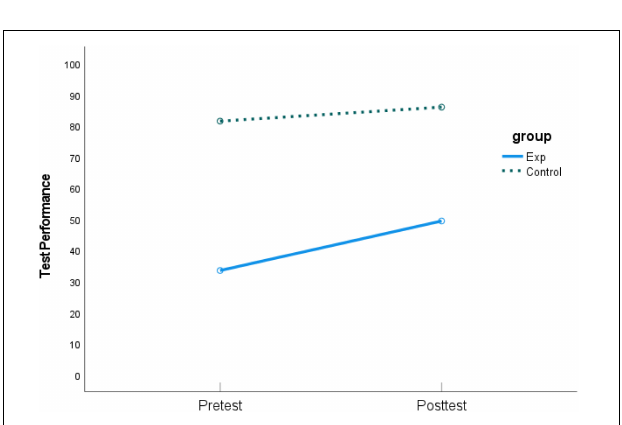
FIGURE 4 | Means of pretest and posttest on English language test